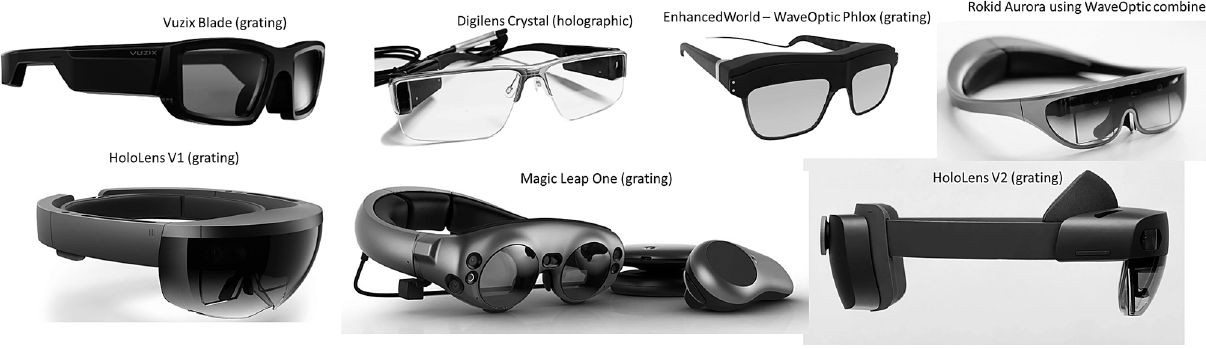
Figure 10: Smart glasses and AR headsets that use 2D EPE diffractive or holographic waveguide